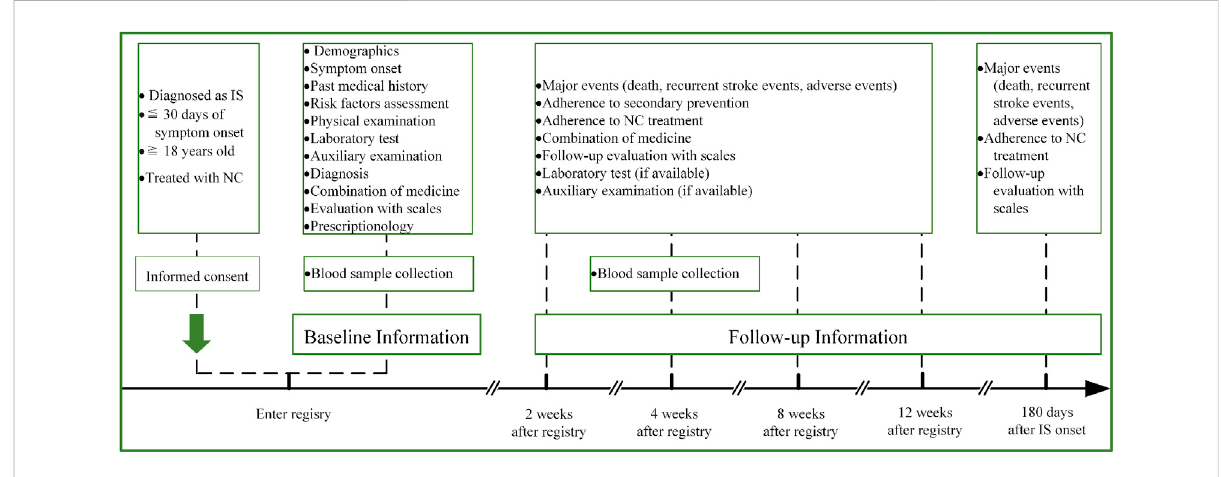
FIGURE 1 Flowchart of the VENUS registry. Abbreviations: IS, ischemic stroke; NC, Naoshuantong